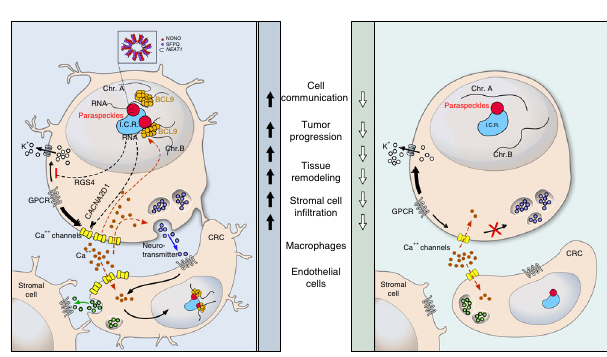
Fig. 7 Model for BCL9-dependent upregulation of calcium wave propagation among CRC cells and with the TME. In wild-type C1 CRC cells (left) (e.g. RKO), the generation of spontaneous calcium transients through voltage-gated calcium channel opening, leads to neurotransmitter release and activation of neighboring cells bearing its receptor (e.g. GPCR) to promote calcium release and wave propagation. Simultaneously, CRC cell stimulation and calcium in fl ux promote BCL9 accumulation around and interaction with paraspeckles, generating a positive feedback loop to stabilize mRNA of calcium associated genes (e.g. CACNA2D1) and ensuring the occurrence of the subsequent calcium transients. Thus, BCL9 translocation into paraspeckles provides C1 CRC cells with neuronal-like properties (e.g. cytoplasmic projections, calcium waves) to enhance communication among tumor cells and cells from the tumor microenvironment; this subsequently promotes tumor progression by enhancing tumor progression, tissue remodeling, stromal cell in fi ltration (e.g. macrophages, and endothelial cells). In C1 cells lacking BCL9 (right), the neuronal-like properties are lost; this is due to the lack of expression of genes associated with the generation of calcium waves, the disruption of the positive feed-back loop, and the fact that calcium waves are not strong enough to induce neurotransmitter release. This consequently terminates the propagation of calcium waves and communication among tumor cells and with the tumor microenvironment. I.R.C. represents interchromosomal